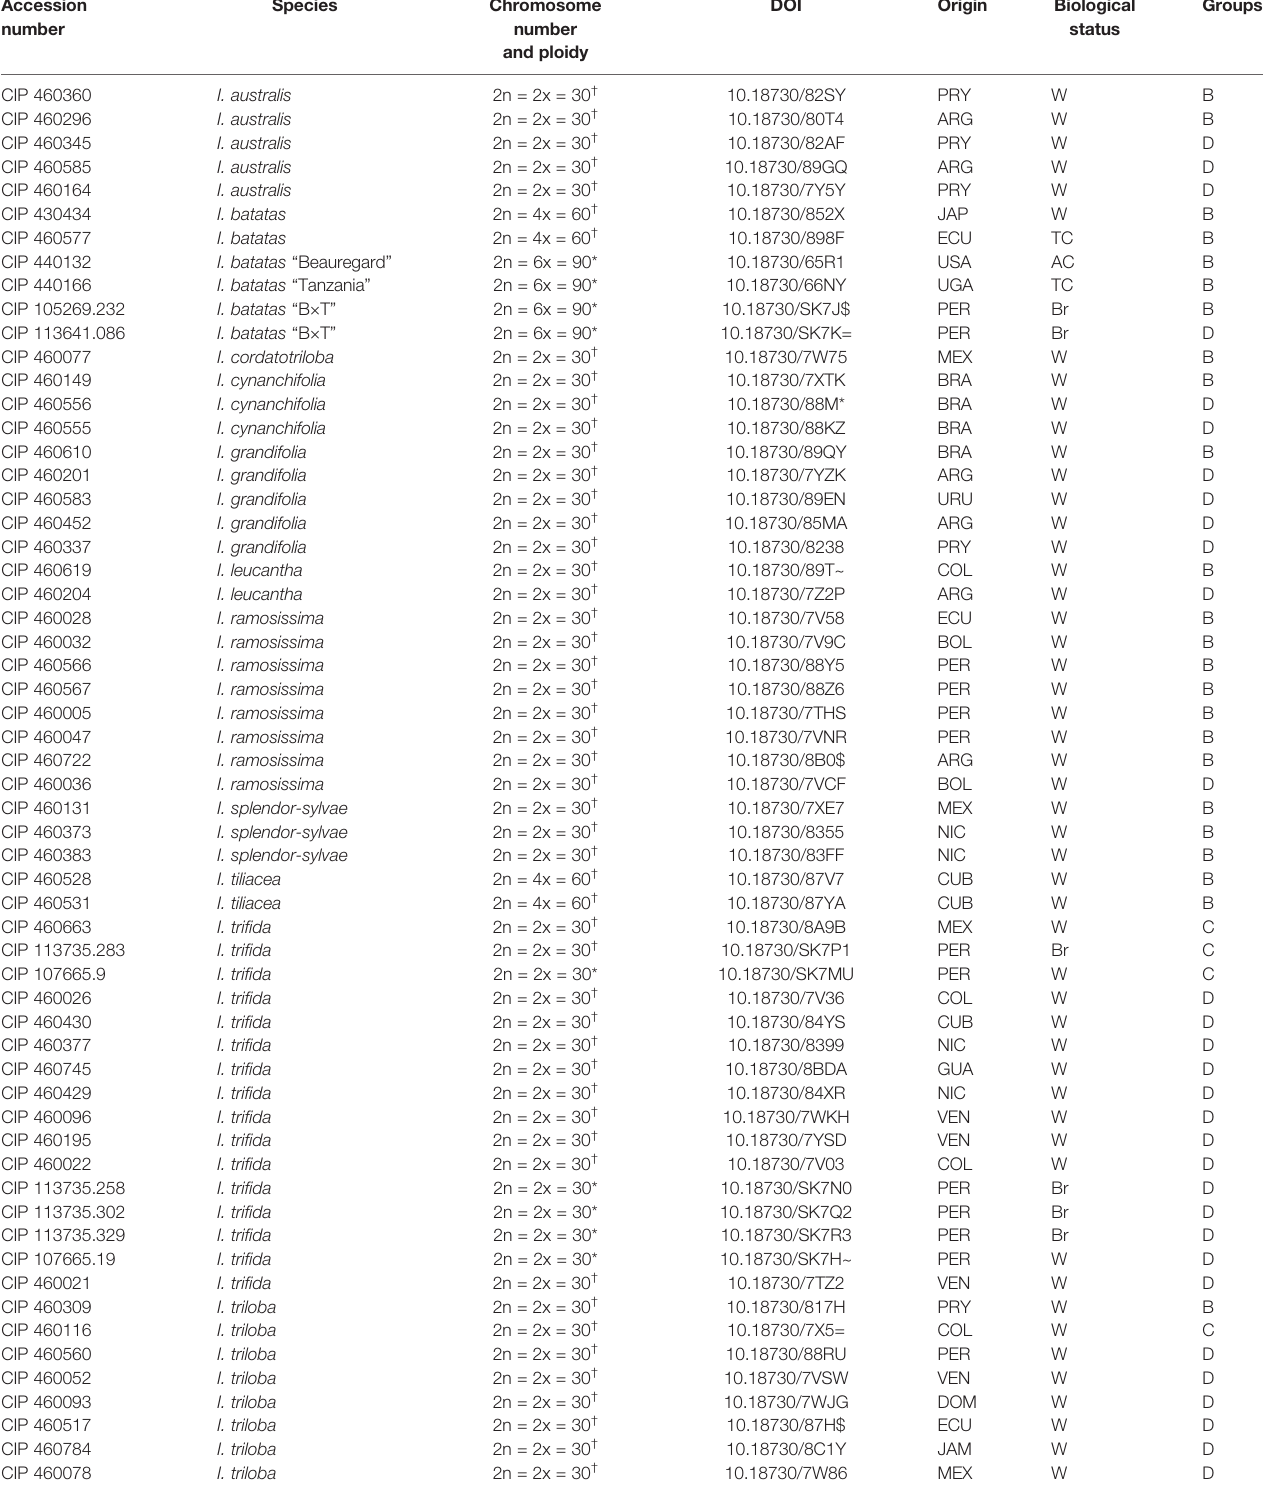
TABLE 1 | Sweetpotato crop wild relatives [ Ipomoea series Batatas (Choisy) D. F. Austin] accessions from CIP ’ s genebank used in this study, with chromosome number and ploidy (basic chromosome number: x=15), country of origin and biological status for each of